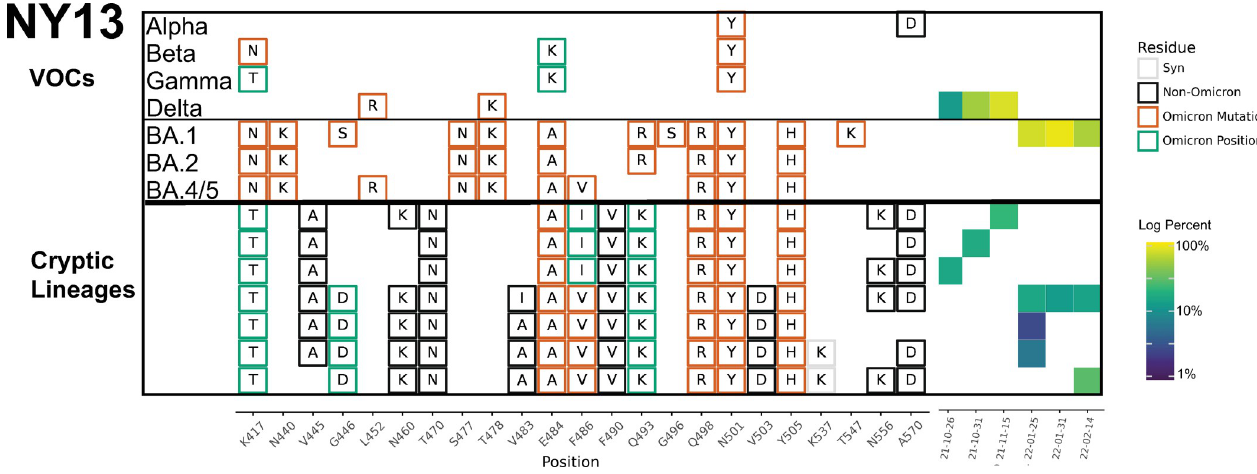
Fig 5. NY13 RBD amplifications. Overview of the SARS-COV-2 Spike RBD lineages identified from the NY13 sewershed. Amino acid changes similar to (green boxes) or identical to (orange boxes) changes in Omicron (BA.1, BA.2 or BA.5) are indicated. Synonymous changes (syn) are indicated in gray. The major VOCs during this time period (Alpha, Beta, Gamma, BA.1 and BA.2) are indicated. The heatmap (right) illustrates lineage (row) detection by date (column), colored by the log 10 percent relative abundance of that lineage. Uncondensed output in S8 Data.